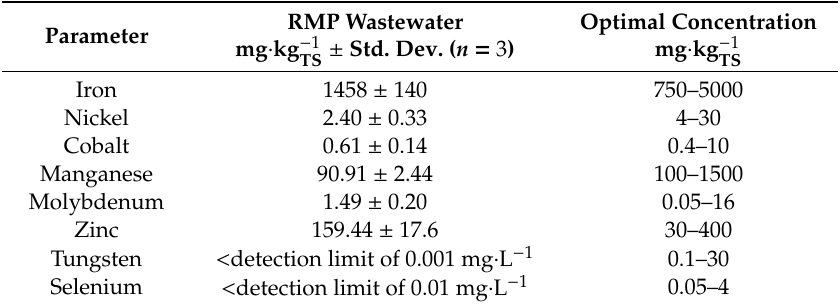
Table 3. Trace element concentrations in red meat processing (RMP) wastewater and recommended optimal ranges